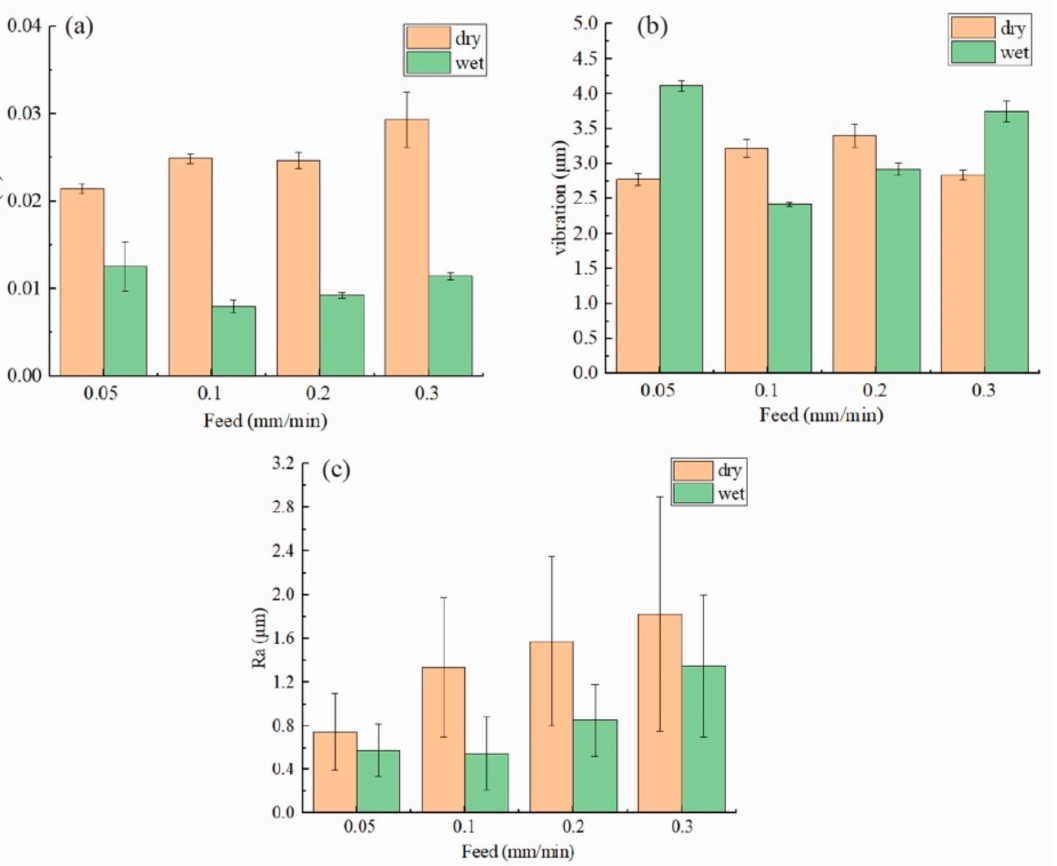
Figure 14. ( a ) The specific cutting force; ( b ) the vibration; ( c ) the surface roughness Ra along the saw mark for both the dry cutting and wet cutting